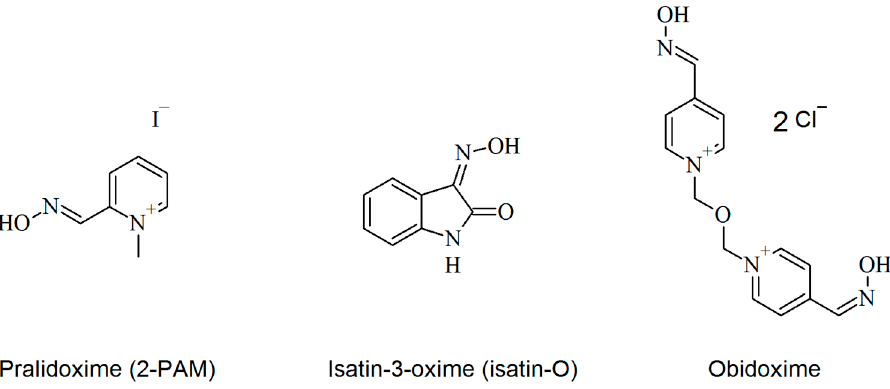
Figure 1. Structures 2-PAM, isatin-O and obidoxime.